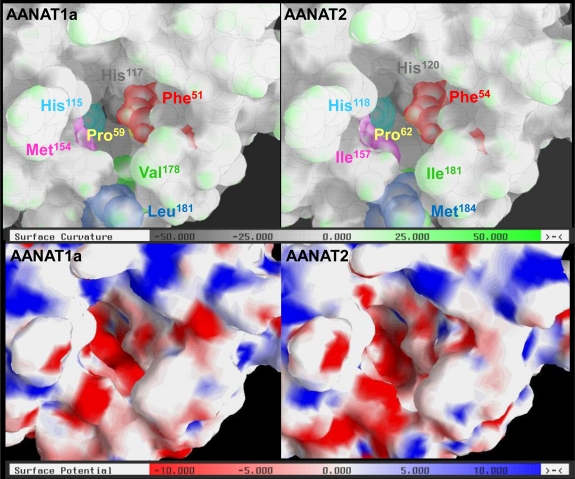
3-D surface properties of the catalytic funnel of seabream AANAT1a and AANAT2. The 3-D models of AANAT1a (left panels) and AANAT2 (right panels) were reconstructed based on the 3-D structure of the sheep AANAT complex with a bisubstrate analog [15]. The curvature analysis of the surface is shown on the upper part of the picture, with the innermost regions colored in grey and the outermost in green (see scale bar). The lower part of the picture depicts the electrostatic properties analysis of the funnel, with the positive parts colored in blue and the negative parts in red (see scale bar). Residues that form the amine binding site and catalytic residues are colored as follows: Phe51(AANAT1a) and Phe54 (AANAT2), red; Pro59 (AANAT1a) and Pro62 (AANAT2), yellow; Met154 (AANAT1a) and Ile157 (AANAT2), magenta; Val178 (AANAT1a) and Ile181 (AANAT2), green; Leu181 (AANAT1a) and Met184 (AANAT2), blue; His115 (AANAT1a) and His118 (AANAT2), cyan; His117 (AANAT1a) and His120 (AANAT2), grey. Grasp software package was used for the surface property analysis.